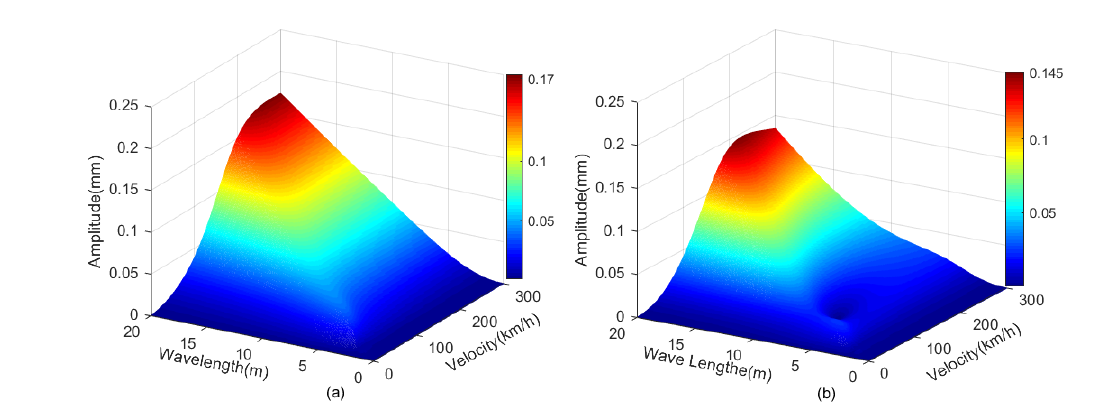
Figure 2. Amplitude spectrums of levitation gaps. ( a ) Gap1 (the back), ( b ) Gap2 (the